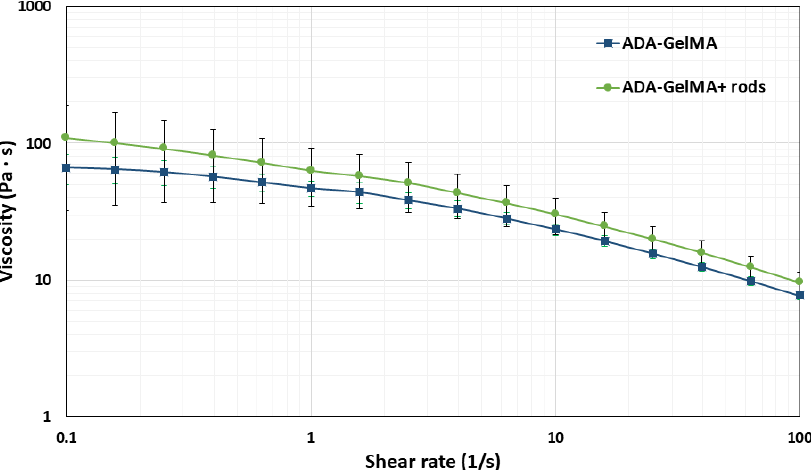
Figure 6. Shear rate (1/s) vs. viscosity for ADA–GelMA blend solution (10 wt%, 2:1), with microrods 200 µm length and without.